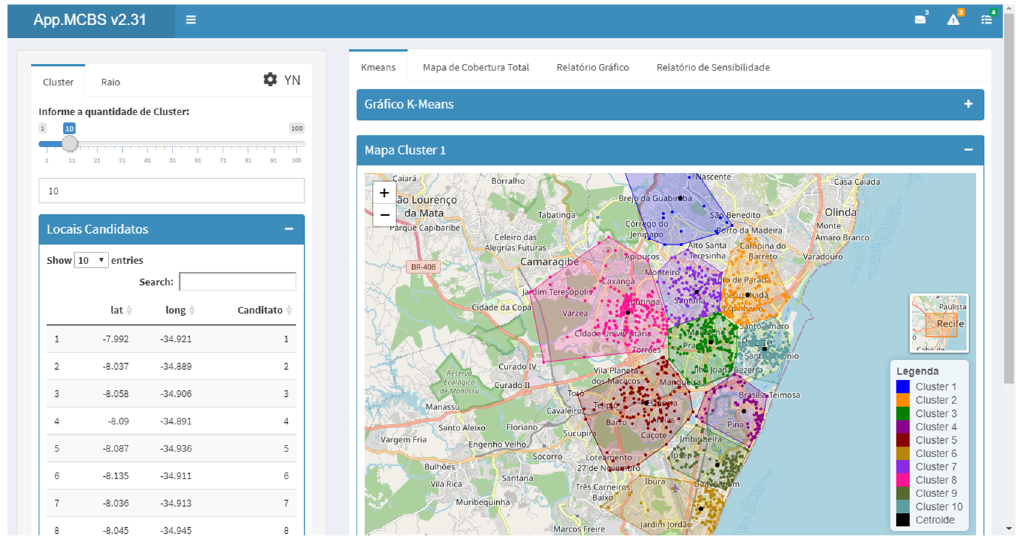
Figure 4. Data analysis visualization screen; k-means recommendation.